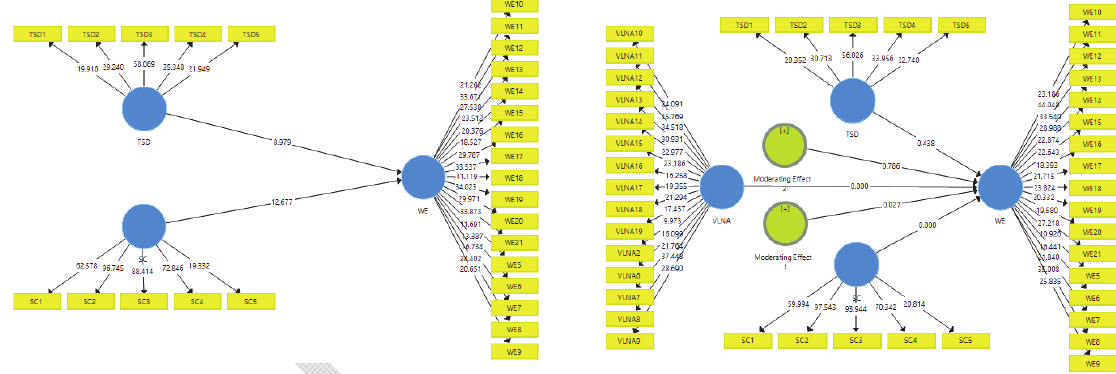
Fig. 3. Structural Model Assessment Fig. 4. Structural Model Assessment (Moderation Effect)